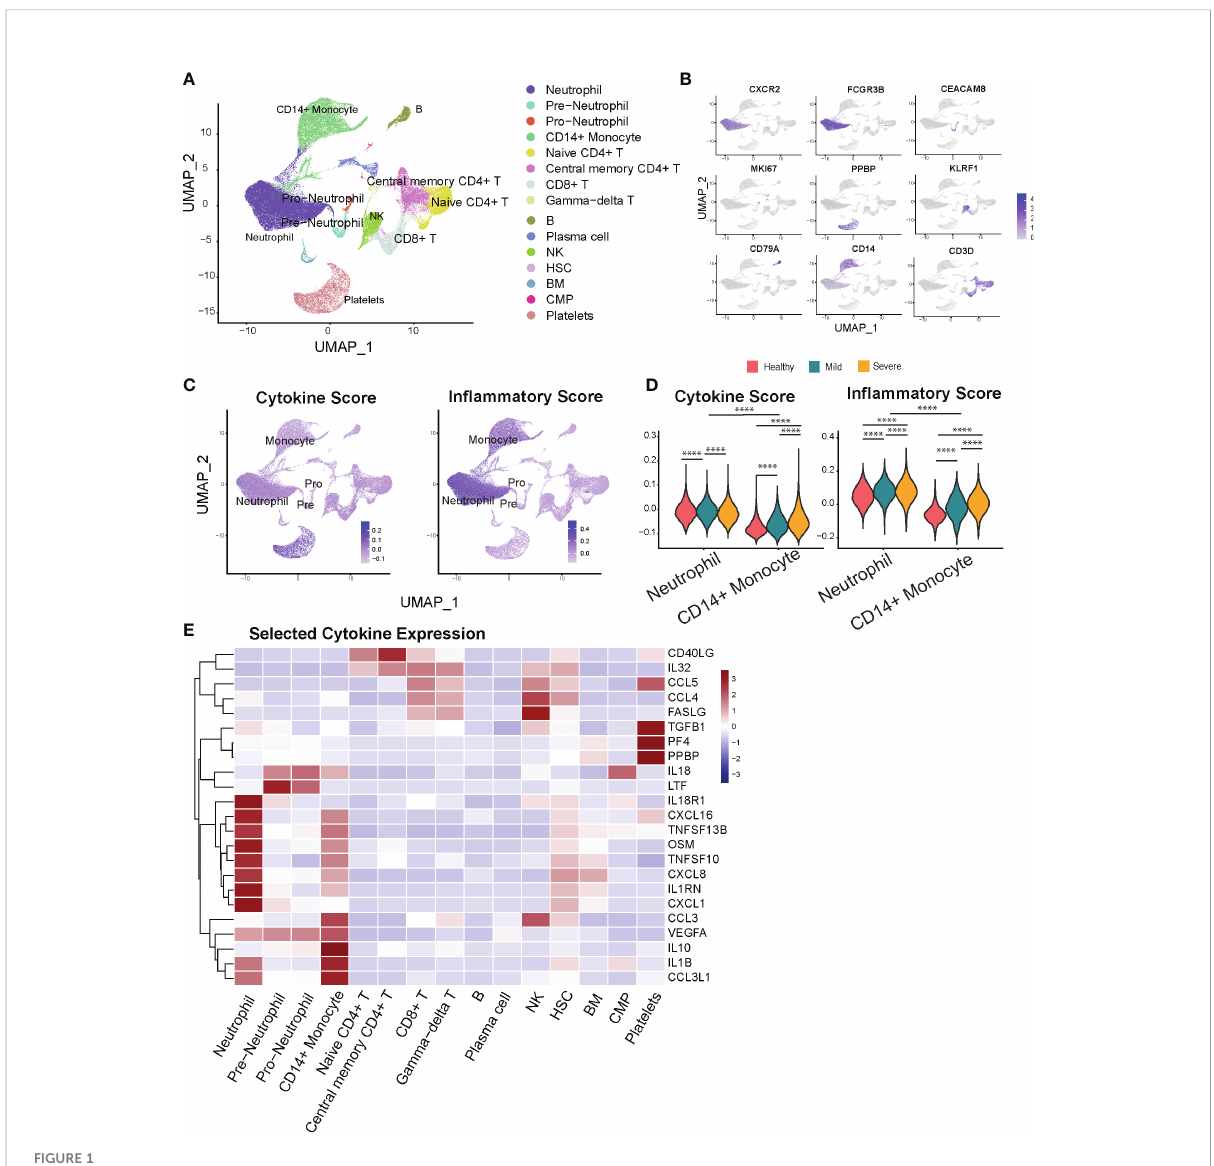
FIGURE 1 Neutrophils display marked in fl ammatory signatures relative to other leukocyte populations. (A) Cellular populations identi fi ed by scRNA seq. The UMAP projection from HD (n=5), Mild (n=4), severe (n=6) samples. (B) Canonical cell-de fi ning transcripts were used to label clusters by cell identity as represented in the UMAP plot. Data are colored according to expression levels and the legend is labeled in log scale. (C) UMAP plots of cells colored by cytokine score (left) and in fl ammatory score (right panel). (D) Violin plots indicate progression of cytokine (left) and in fl ammatory scores (right panel) for neutrophils and monocytes with increased severity of infection. (E) Heatmap of selected cytokine genes in different subsets of cells. ****p <